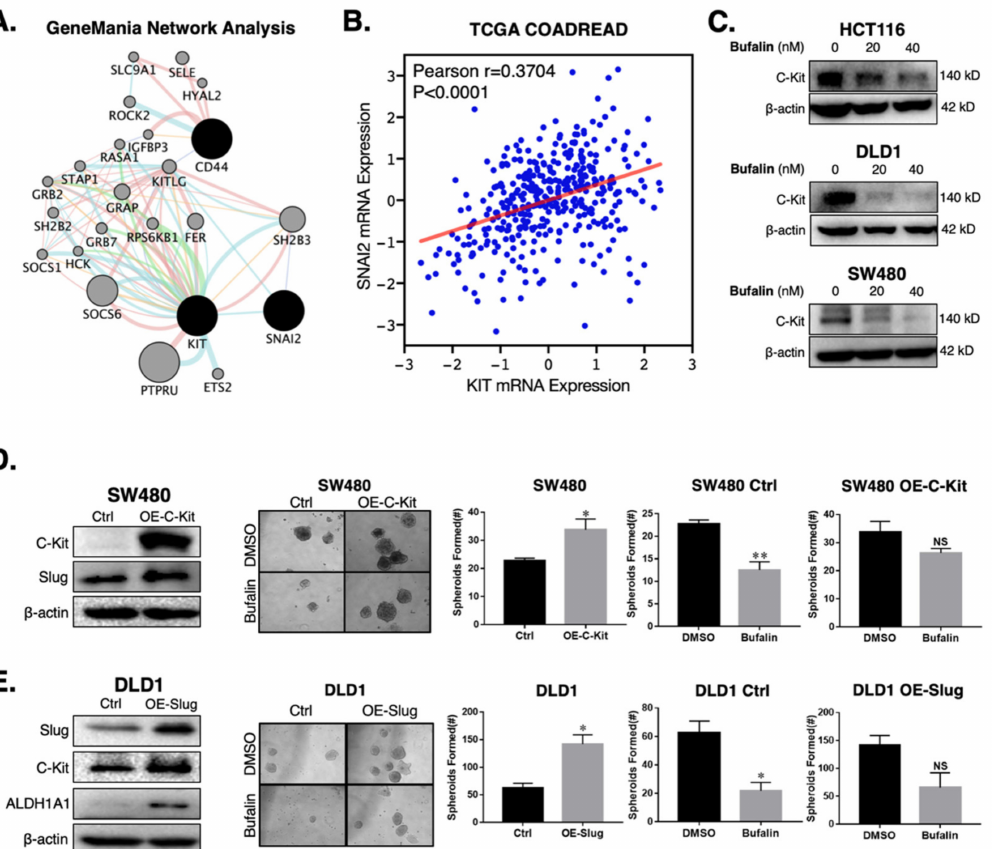
Figure 3. C-Kit and Slug form a positive-feedback signaling axis in CRC, which is a target of bufalin’s anti-stemness activity. ( A ) GeneMANIA network analysis showing that C-Kit (KIT) and Slug (SNAI2) are pathway interactors. ( B ) Correlation analysis from TCGA’s COADREAD RNA-Seq dataset demonstrating that the mRNA expression of C-Kit and Slug are positively correlated (Pearson r = 0.3704, p < 0.0001). ( C ) Immunoblotting results confirming that C-Kit is strongly downregulated following 20 or 40 nM bufalin treatment in HCT116, DLD1 and SW480 cell lines. ( D ) Overexpression of C-Kit (OE-C-Kit) in the SW480 cell line results in up-regulation of Slug, increased matrigel spheroid formation capacity at baseline (~50% increase; p < 0.05), and resistance to bufalin’s anti-stemness activity as evidenced by an approximately 50% reduction in vector control spheroids (SW480 Ctrl; p < 0.01) compared to a <20% reduction in OE-C-Kit spheroids (SW480 OE-C-Kit; NS). ( E ) Slug over-expression (OE-Slug) in the DLD1 cell line results in upregulation of C-Kit and ALDH1A1, increased matrigel spheroid formation capacity at baseline (>100% increase; p < 0.05), and resistance to bufalin’s anti-stemness activity as evidenced by an approximately 66% reduction in vector control spheroids (DLD1 Ctrl; p < 0.05) compared with a statistically insignificant reduction in OE-C-Kit spheroids (DLD1 OE-C-Kit; NS). (* p < 0.05, ** p < 0.01, NS = Not